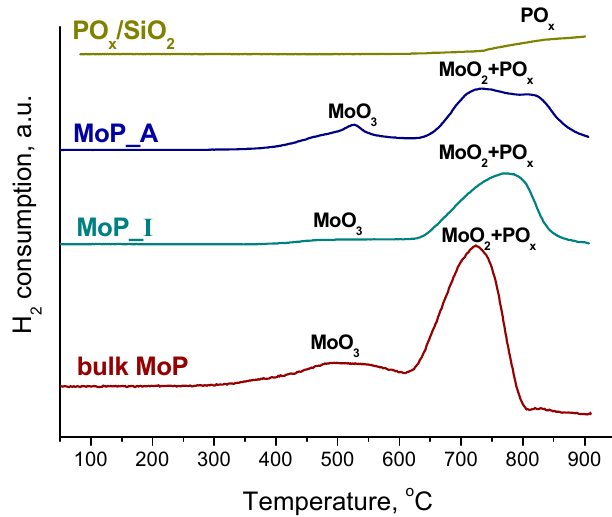
Figure 1. H 2 -TPR curves of PO x /SiO 2 , supported MoP_A, MoP_I and bulk MoP oxide